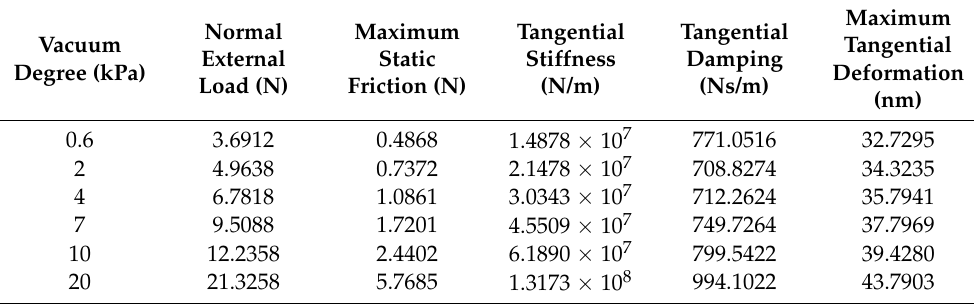
Table 3. Contact parameters between reticle and chuck under different vacuum degrees.